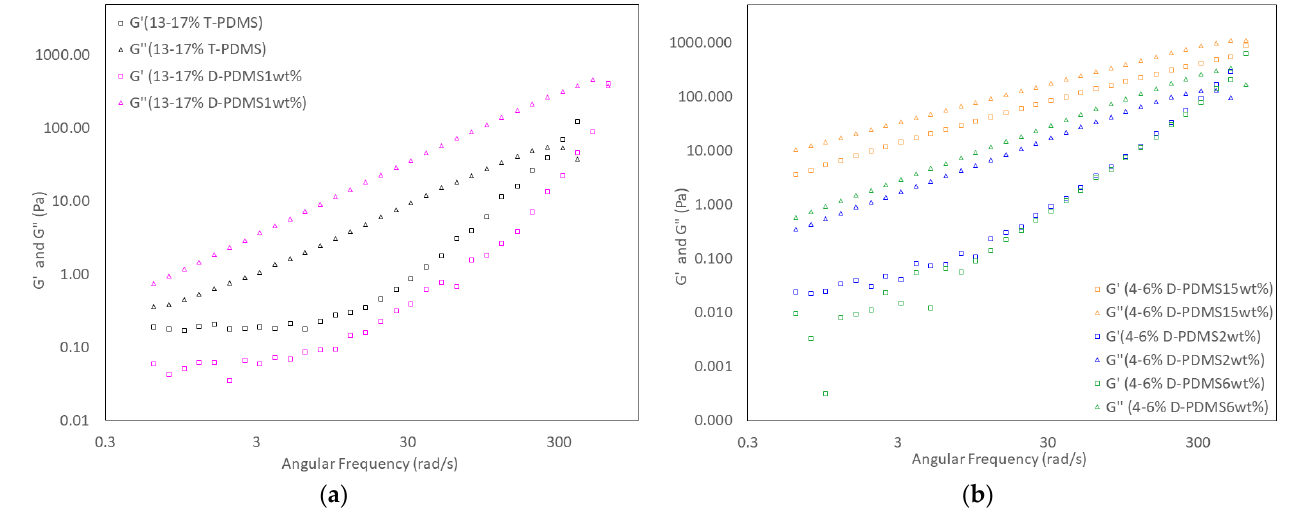
Figure 5. Frequency sweeps at 1% strain: ( a ) 13 – 17% T-PDMS and liquid 13 – 17% D-PDMS 1wt% ; ( b ) liquid 4 – 6% D-PDMS materials.